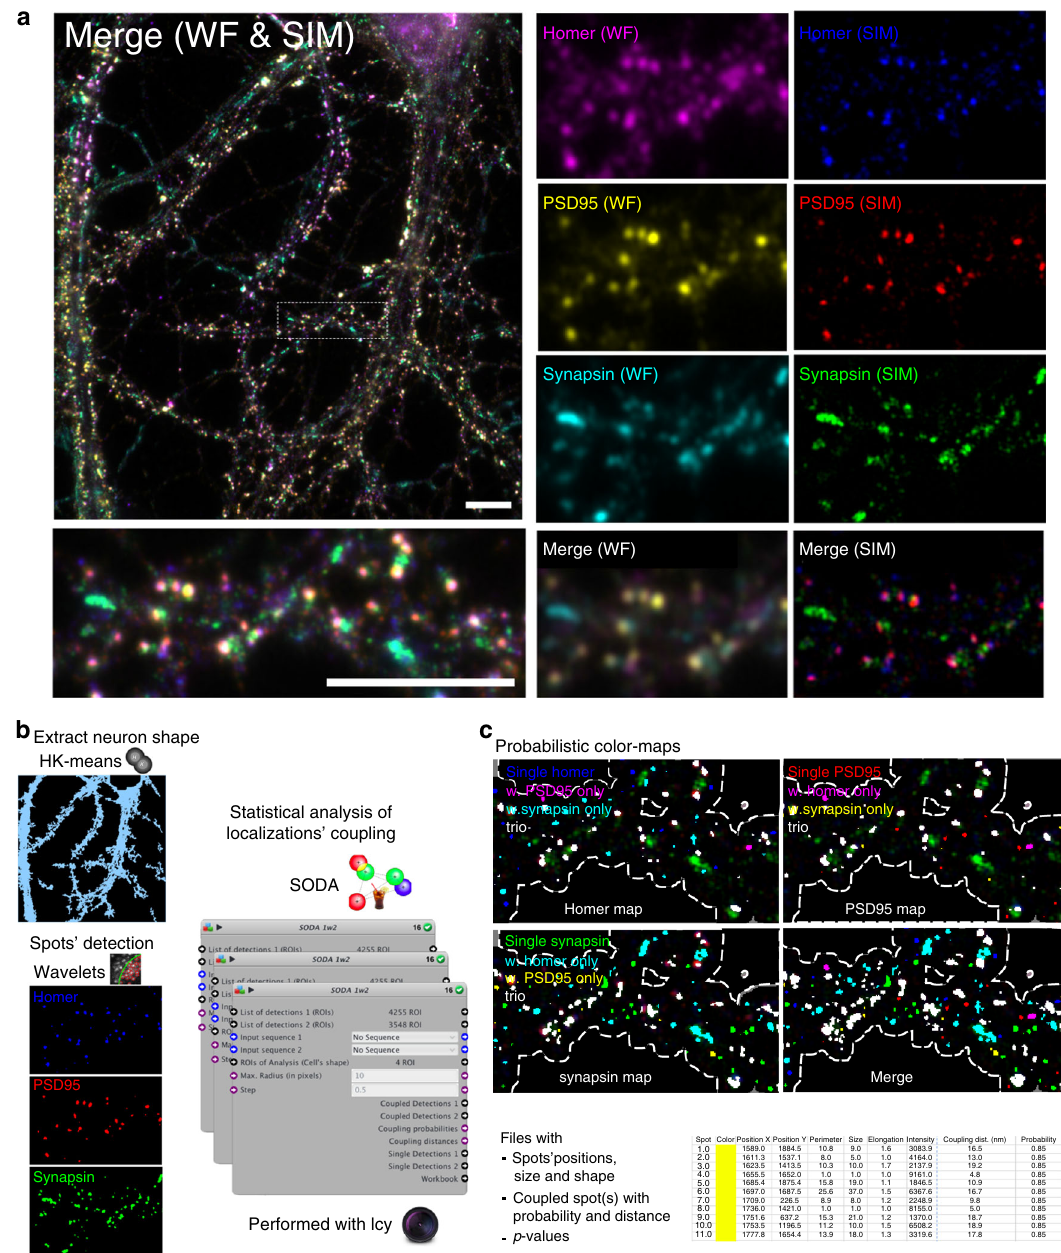
Fig. 3 Batch analysis using graphical programming in Icy. a The input of SODA protocol is a folder that contains multiple three-colour SIM images of primary hippocampal neurons. Postsynaptic anchoring molecules PSD95 (red) and Homer (blue), and the presynaptic molecule Synapsin (green) are labelled. b The publicly available protocol consists of multiple elementary blocks that sequentially perform multiple image analysis. (i) Cell body and neuronal shape are isolated with two HK-means thresholdings of Homer labelling. Dendritic mask is then obtained by substracting the cell body mask to the neuronal mask. (ii) Spot detector blocks extract pre- and postsynaptic spots inside the dendritic mask. (iii) SODA blocks analyse the coupling between the localisations of PSD95, Homer and Synapsin spots statistically. The complete screenshot of the protocol is shown in Supplementary Fig. 3. c Outputs of SODA protocol are: (i) the probabilistic colour maps of PSD95, Homer and Synapsin spots, where different colour masks are associated to isolated (single) spots, coupled spots and triplets, and (ii) fi les where the positions of each spots, their individual morphology (size, intensity, shape … ), the distance to eventual associated spot(s) and corresponding coupling probabilities are exported automatically. Scale bar = 10 μ assemblies shows that Homer clusters are slightly peripheral compared to the PSD95-Synapsin principal axis, indicating an arrangement of the triplet PSD95-Homer-Synapsin in an asymmetric triangle.